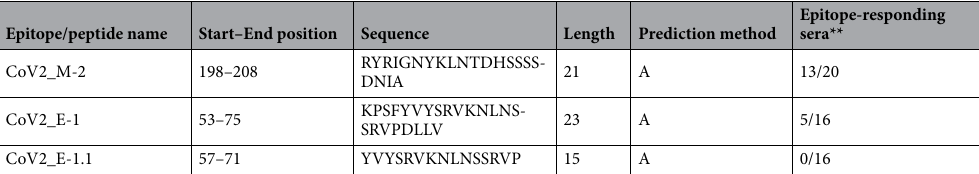
Table 1. Profiles of the B cell epitopes in the S, M and E proteins of the SARS-CoV-2 identified by immunoinformatics approach and validated with COVID-19 convalescent sera. Epitopes in the RBD are highlighted in bold. **Convalescent serum with the OD450 higher than OD450 mean of healthy control group +